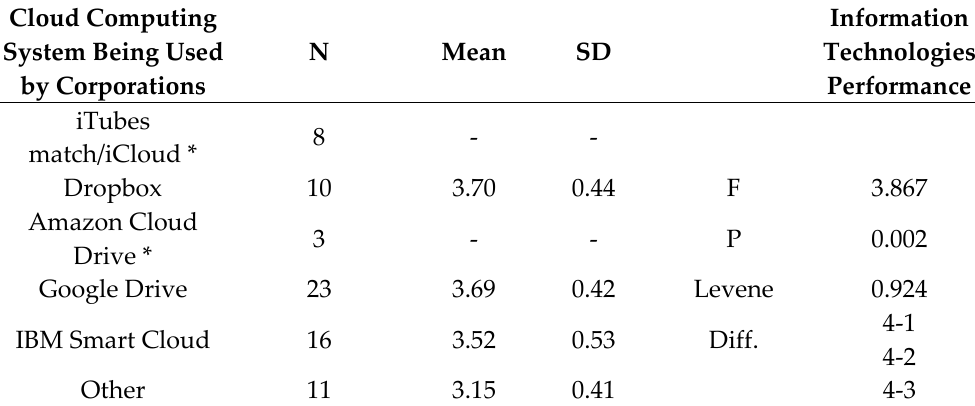
Table 3. Diversification situations in points gained from information technologies performance scale by participants who use a cloud computing system in their corporations with respect to their cloud computing